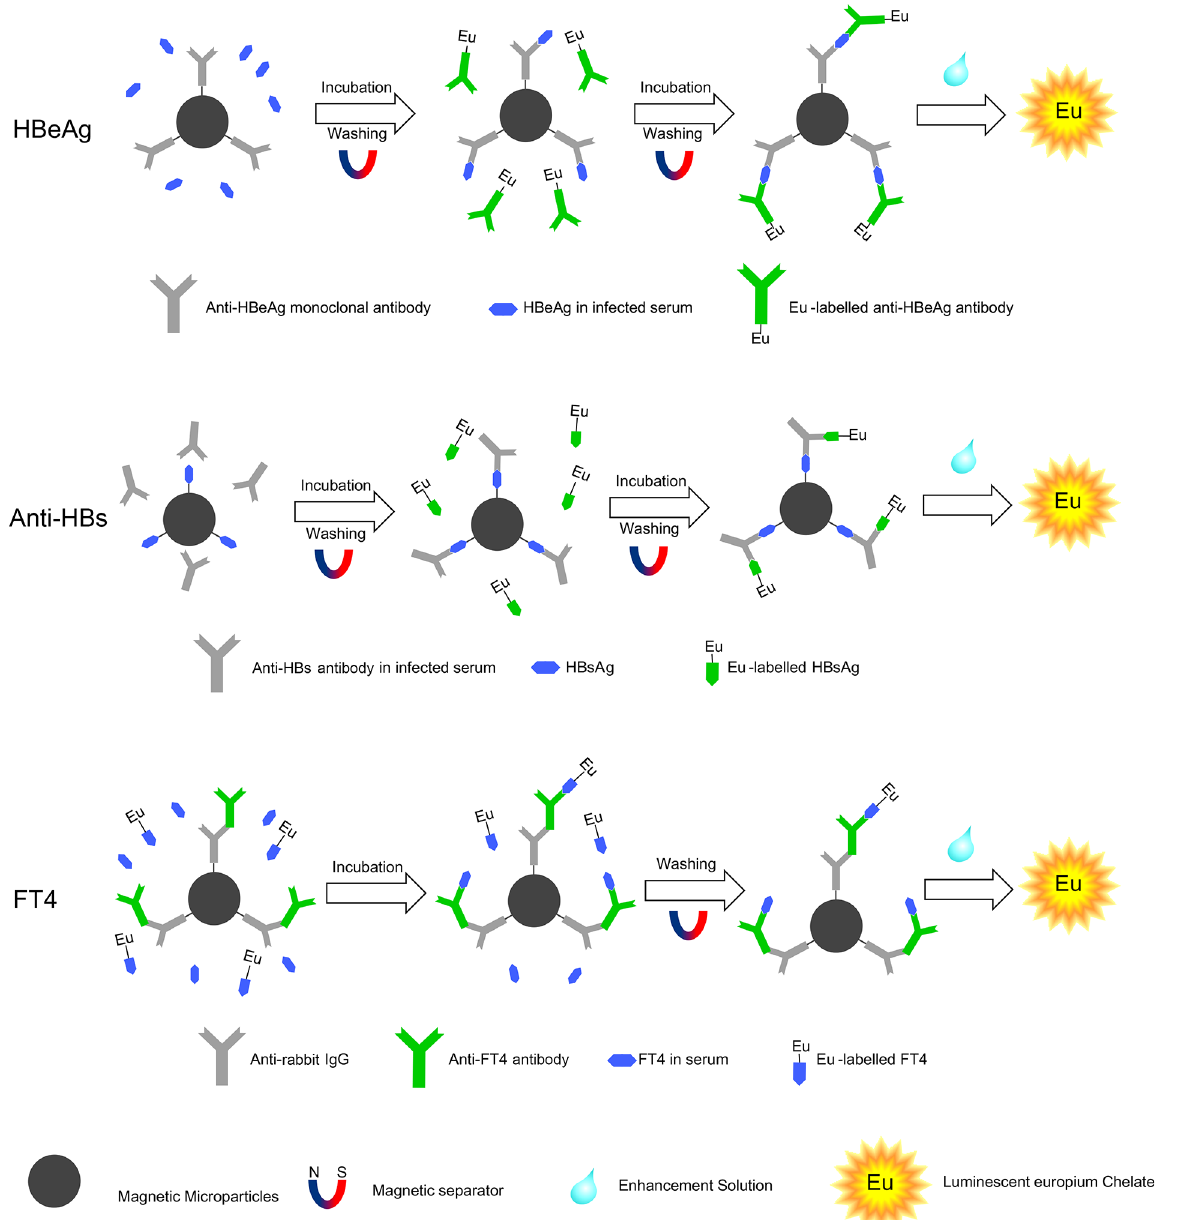
Fig 1. Schematic diagram of the MMPs-TRFIA for determinations of HBeAg, Anti-HBs and